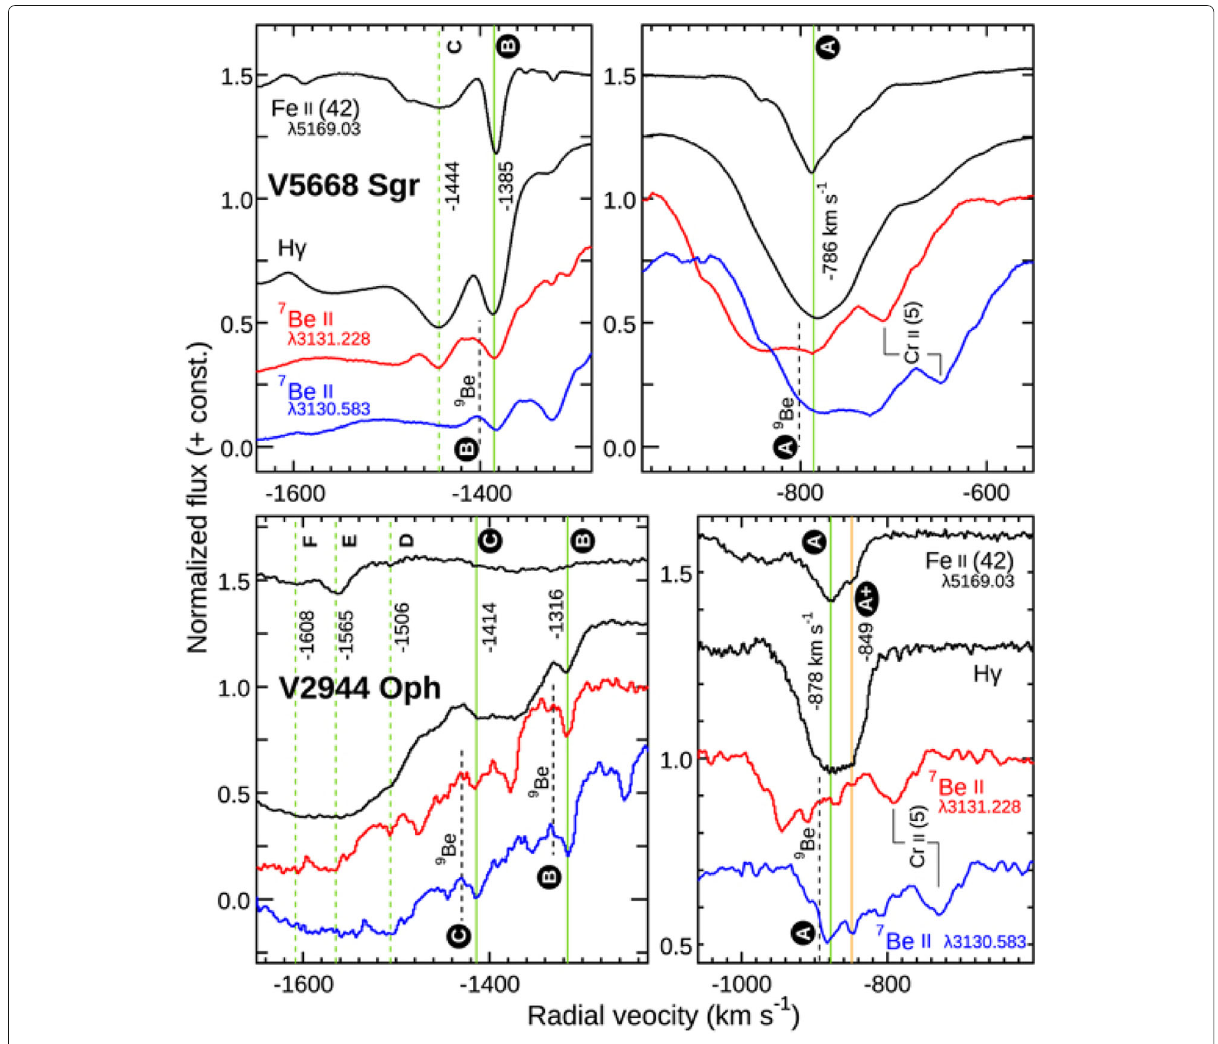
Fig. 2 7 Be spectra detected in novae explosions [34]